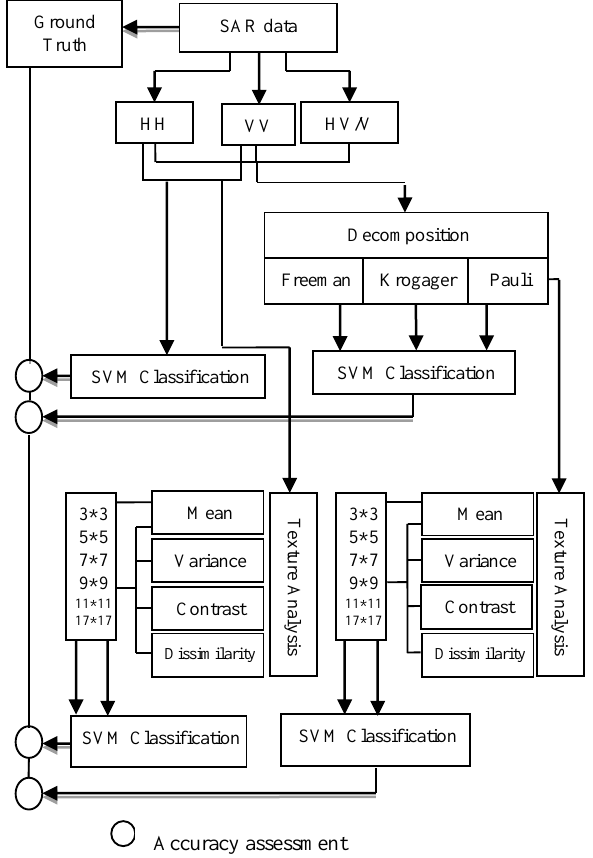
Figure 2. Flowchart of the proposed algorithm